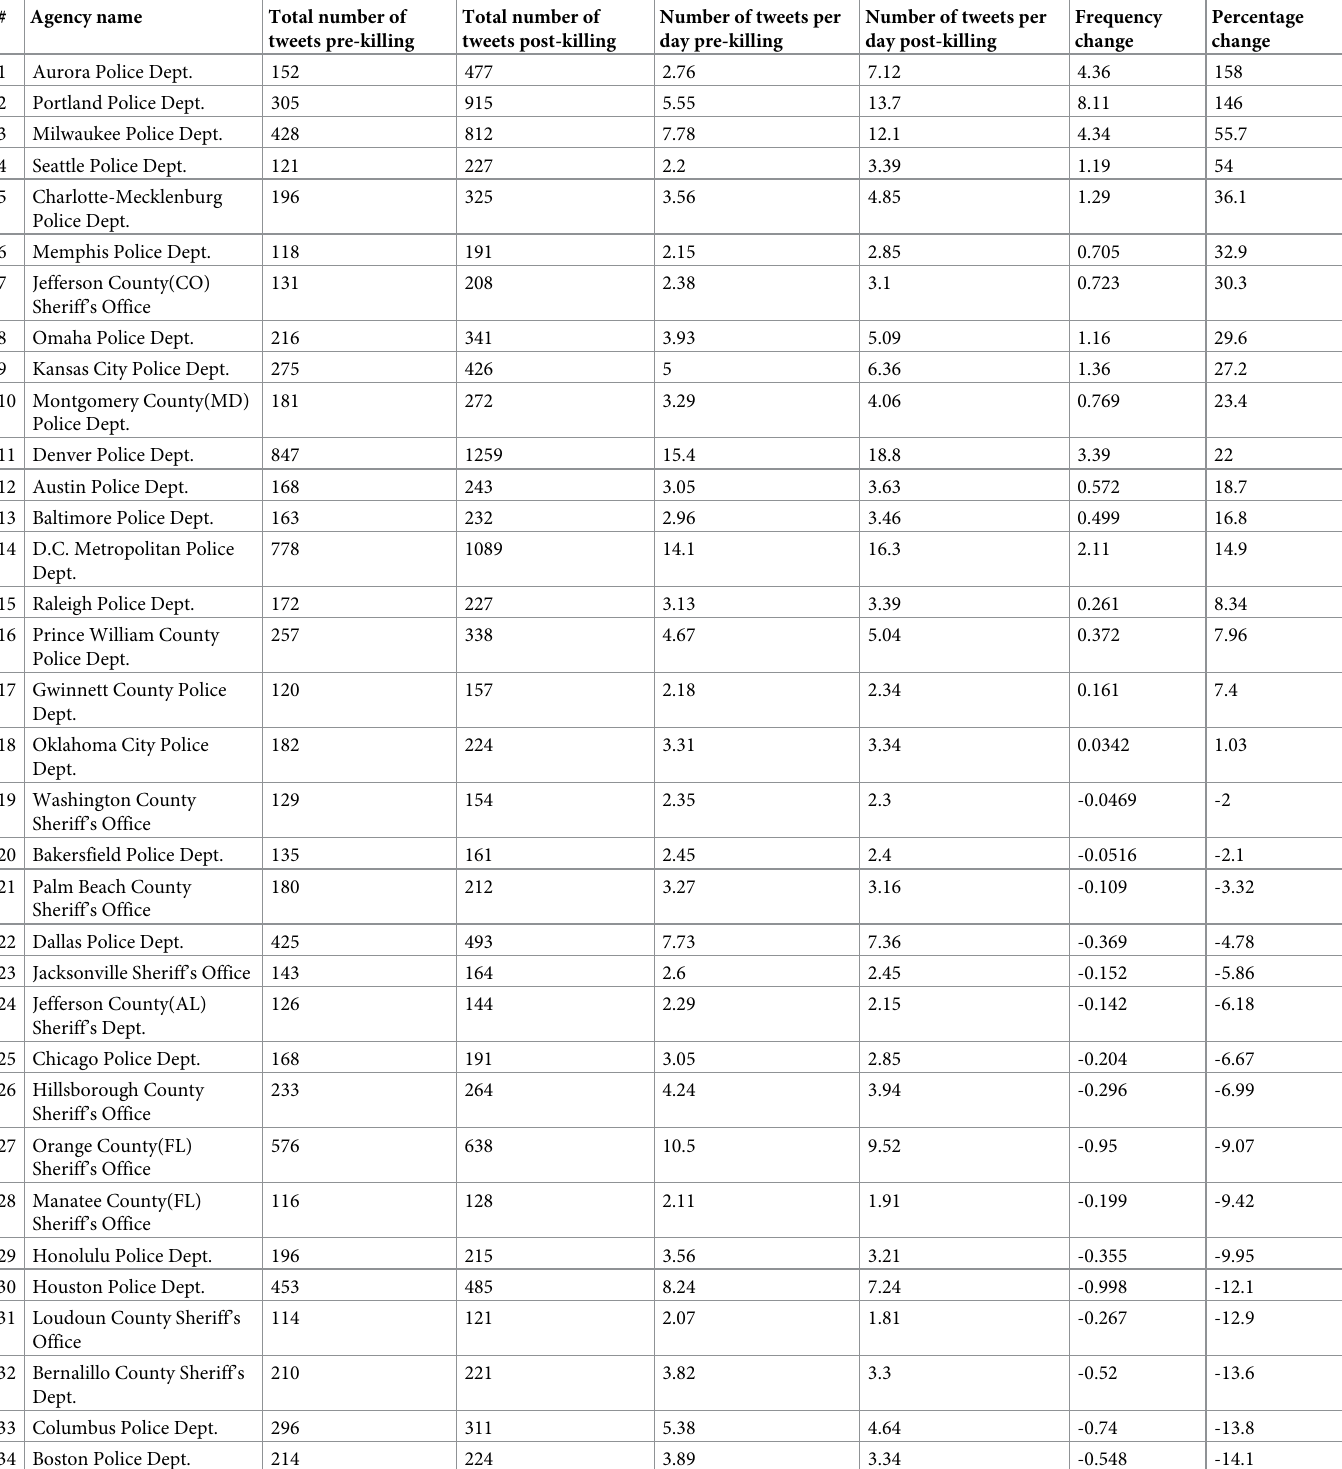
Table 3. Agencies (in the higher-use group) ranked by the increase in the number of tweets posted before and after the